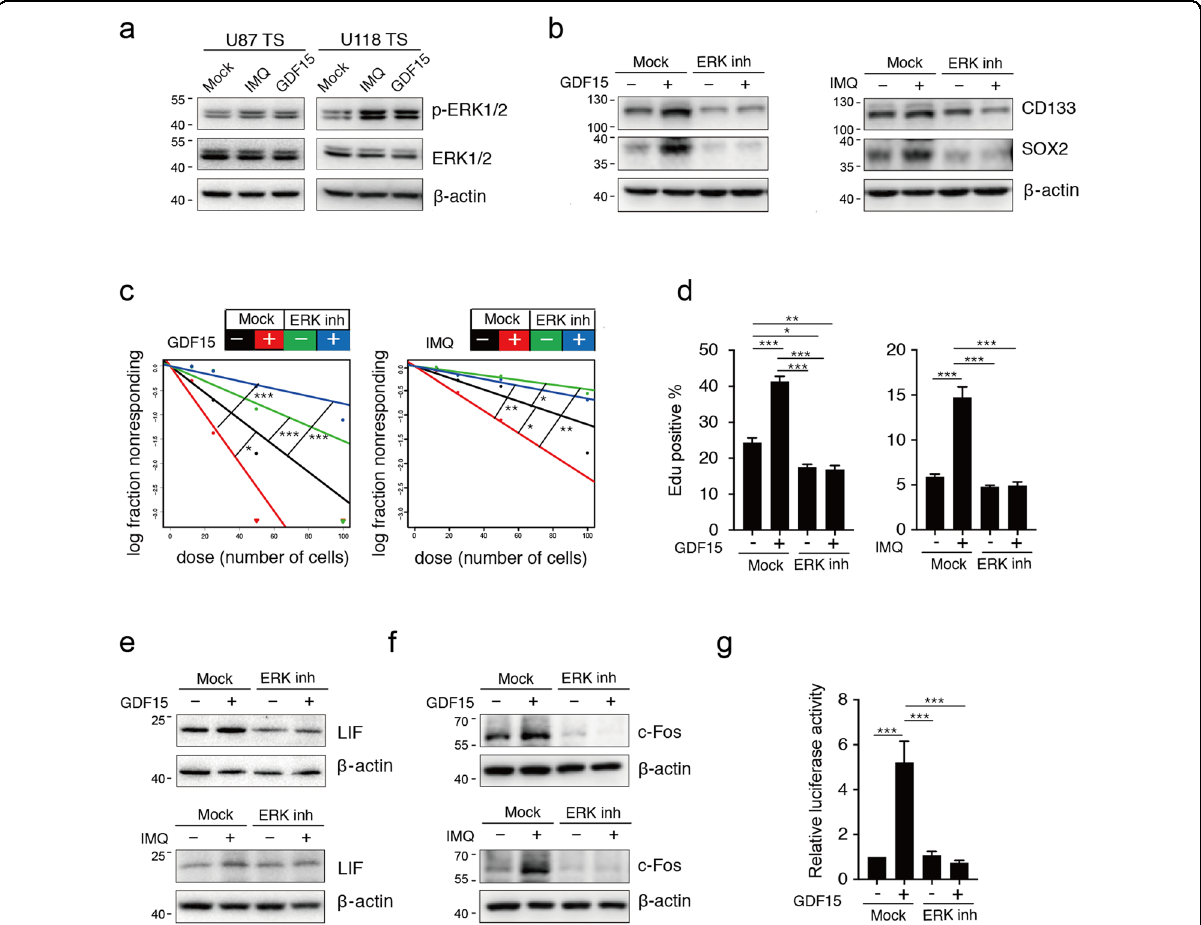
b Immunoblotting analysis of CD133, SOX2, and β -actin expression in U87 TS cells after treatment with the ERK1/2 inhibitor PD98059 for 2 h and then with GDF15 and IMQ for 5 days. c Effects of ERK1/2 inhibitor on the induction of sphere formation by U87 TS cells in response to GDF15 and IMQ as determined by extreme limiting dilution assay ( n = 12). * P < 0.05, ** P < 0.005, *** P < 0.0005; likelihood ratio test. d Cell division among U87 TS cells treated with GDF15 and IMQ after PD98059 treatment, as determined by EdU incorporation assay. e-f Immunoblotting analysis of LIF, c-Fos, and β -actin expression in U87 TS cells treated with the ERK1/2 inhibitor PD98059 for 2 h and then GDF15 and IMQ for 5 days, respectively. g Luciferase activity detected in U87 TS cells transfected with a LIF luciferase reporter for 48 h following pretreatment with PD98059 for 2 h and then treatment with GDF15. Values in d and g represent mean ± s.e.m. * P < 0.05, ** P < 0.005, *** P < 0.0005. One-way ANOVA with Tukey ’ s multiple comparison